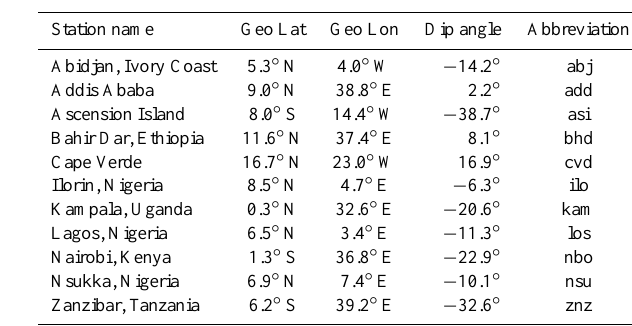
Table 1. SCINDA station locations in Africa. Station dip angles are calculated using IGRF model for the altitude of